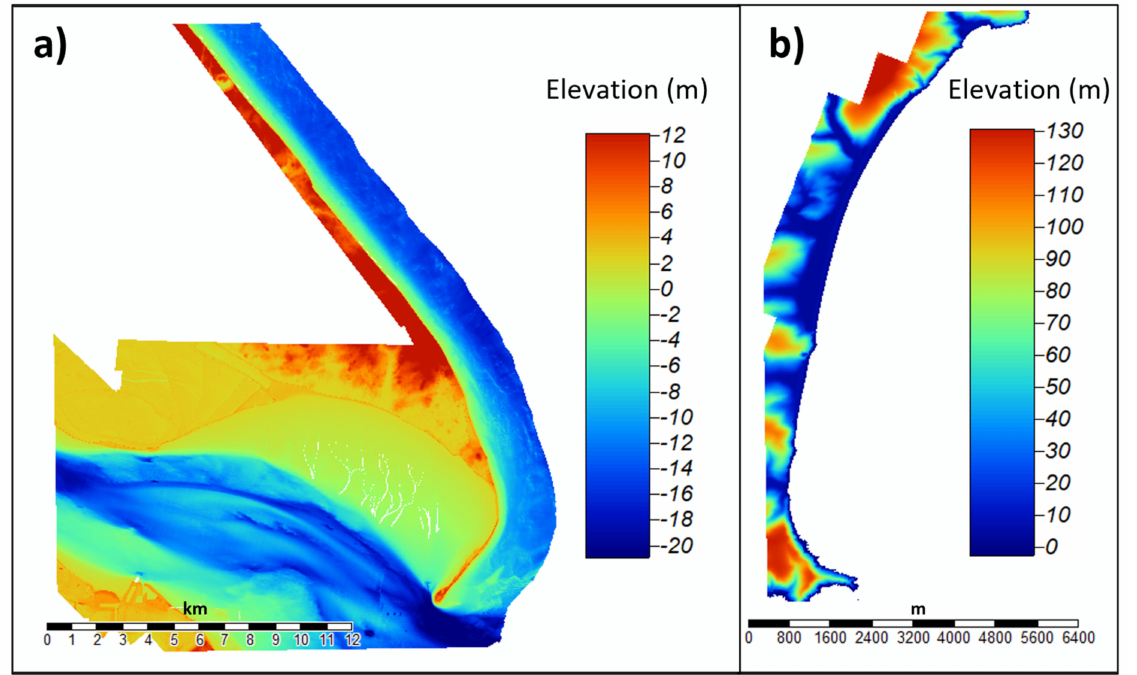
Figure 5. Digital Elevation Models used for validation for Spurn Head ( a ) and Start Bay ( b ). Source DEM: © Environment Agency copyright and/or database right 2021. All rights